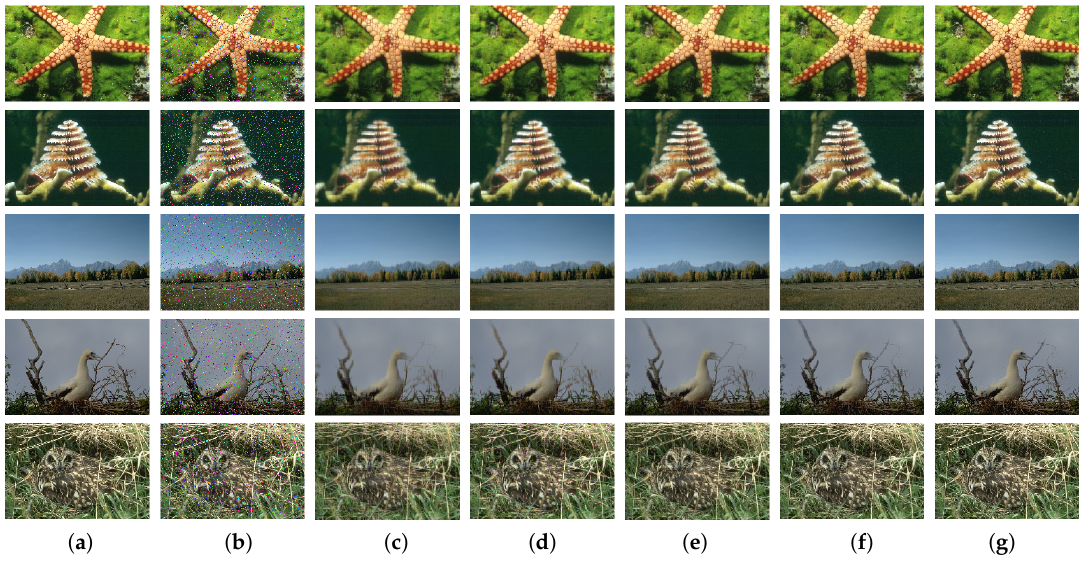
Figure 2. Recovery results on 5 sample images. The first two columns are original and corrupted images reps. The third to seventh columns are recovery images obtained by RPCA, Gamma, SNN, TRPCA and t-Gamma resp. ( a ) Original; ( b ) Corrupted; ( c ) RPCA [4]; ( d ) Gamma [26]; ( e ) SNN [49]; ( f ) TRPCA [20]; ( g )